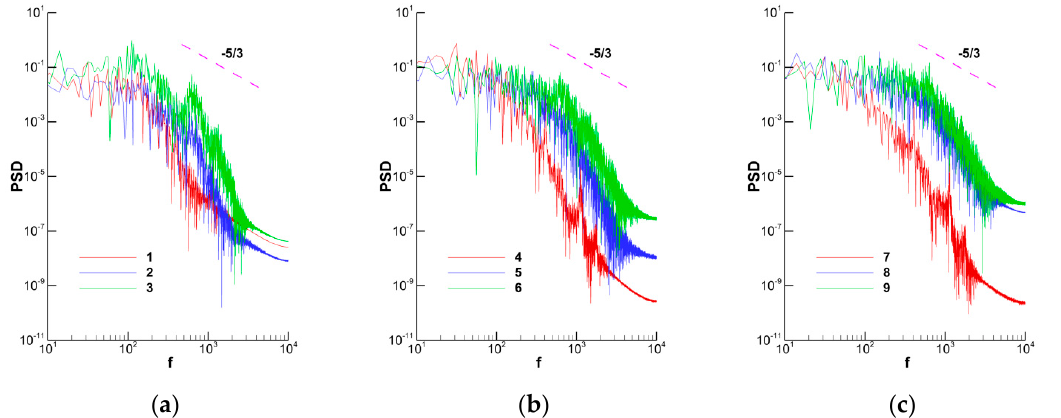
Figure 21. Energy spectra at different spans: ( a ) 10% span; ( b ) 20% span; ( c ) 30% span.